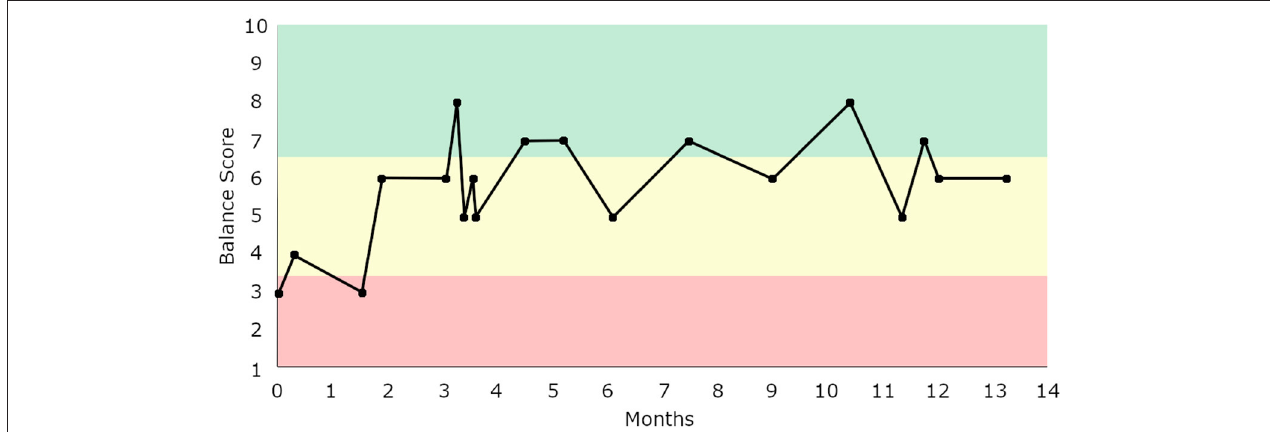
FIGURE 1 | Balance score tracking for a representative older adult who self-selected to assess their postural stability 18 times over the span of 14 months. This individual transitioned from initially scoring in the “high risk” zone (1–3) to comfortably staying within the “moderate risk” zone (4–6), occasionally entering the “low risk”